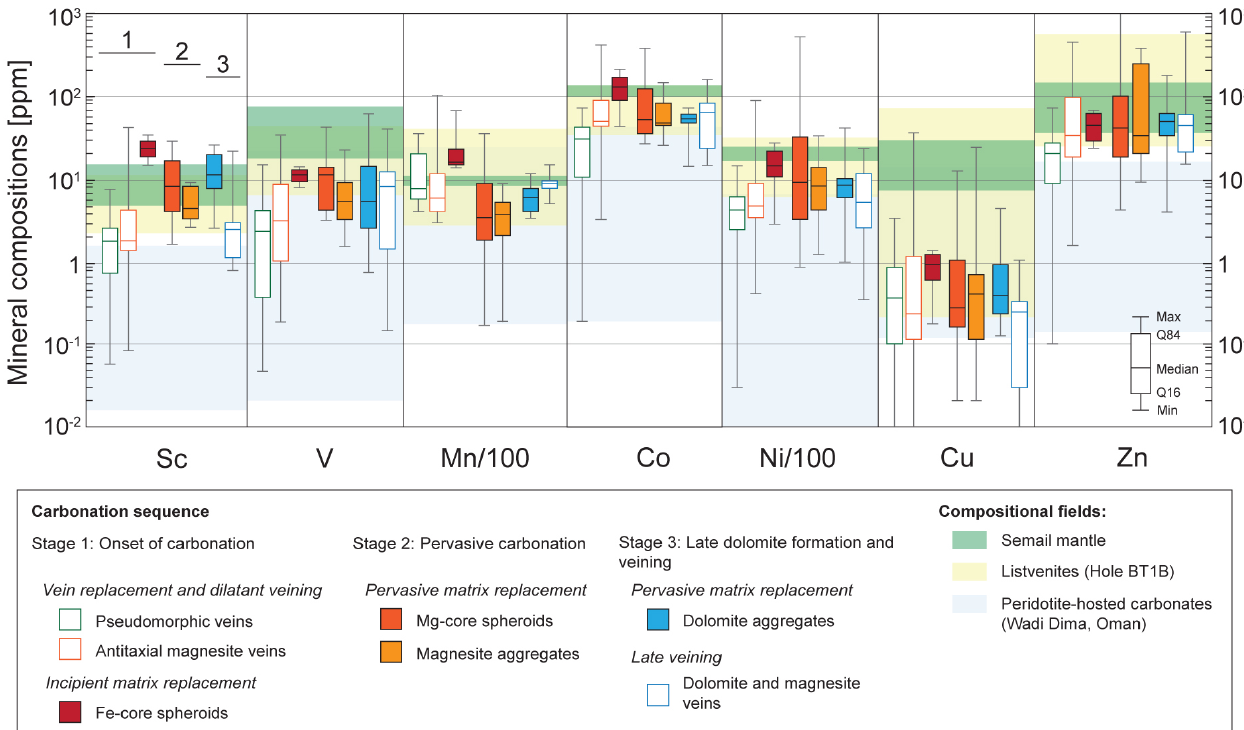
Figure 6. Caltech diagrams of the carbonate compositions in transition metals plotted on a log scale. The compositions of BT1B listvenites and the Semail mantle (data from Godard et al., 2021) and hydrothermal carbonates in the Semail Ophiolite (data from Noël et al., 2018) are represented by the colored background